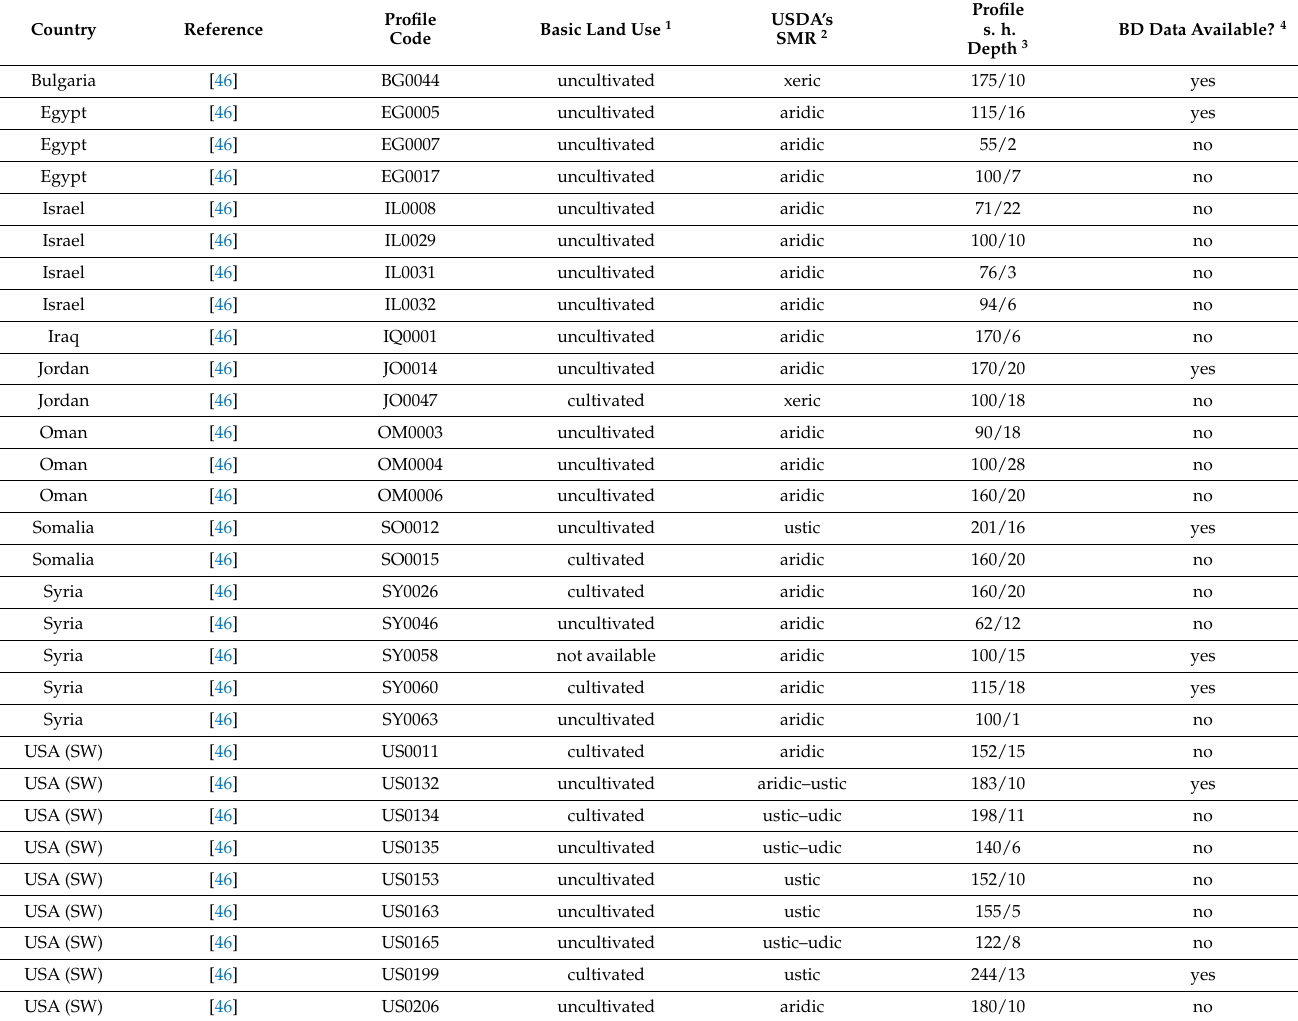
Table 1. Soil profiles used in this study. Basic location, depth data, and information